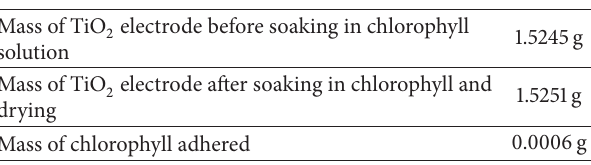
1.5245 g 1.5251 g